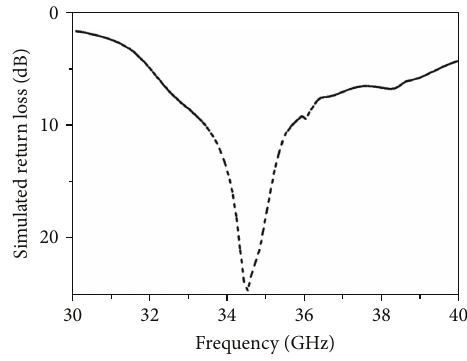
Figure 2: Simulated return loss of the SIDRA element.